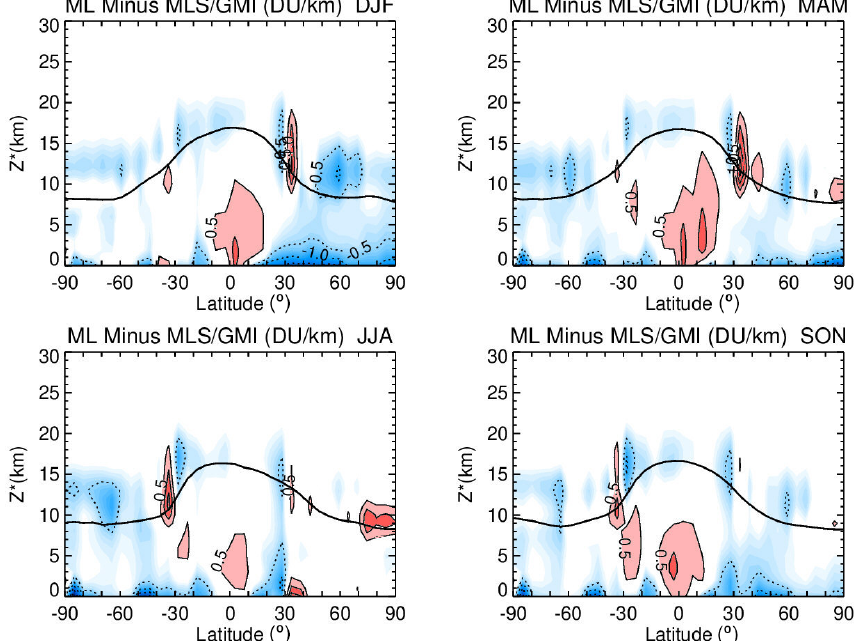
Figure 4. Meridional cross sections of ML minus MLS/GMI climatologies of ozone column concentration (DUkm − 1 ). These differences are averaged over 3-month seasons (indicated) for 2004–2016 and are binned for 10 ◦ latitude bands and Z ∗ levels from 0 to 30km at 1km spacing. Contour levels (indicated) are at 0.5 DUkm − 1 increments: blue and dashed contours mean negative, and pink and red solid contours mean greater than 0.5DUkm − 1 . The black line indicates tropopause height according to the WMO 2Kkm − 1 lapse-rate tropopause definition using NCEP temperatures. White color denotes zero